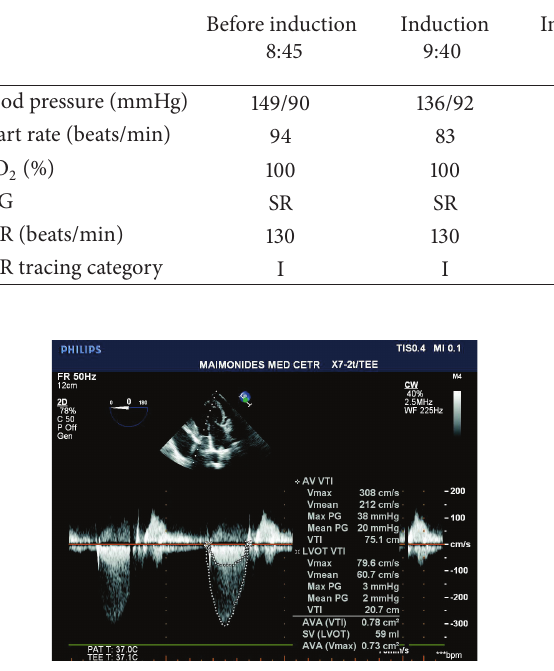
Figure 3: TEE image of the deep transgastric long axis (Deep TG LAX) view measuring the gradient through the aortic valve and LVOT (two of three measurements used to calculate the aortic valve area using the continuity